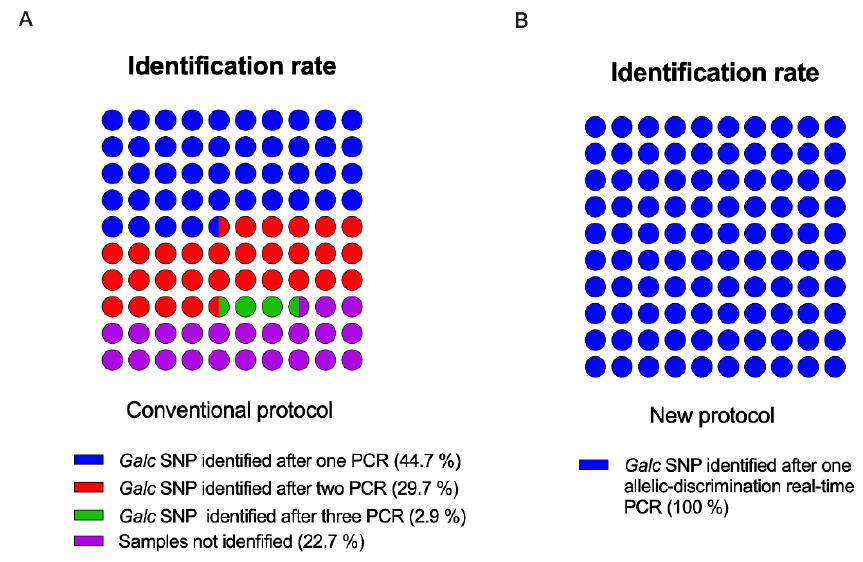
Figure 6. Identification rate of Galc SNP in the Twitcher (Twi) mouse using the conventional protocol ( A ) and of the new protocol based on the allele-discrimination real-time PCR ( B ).